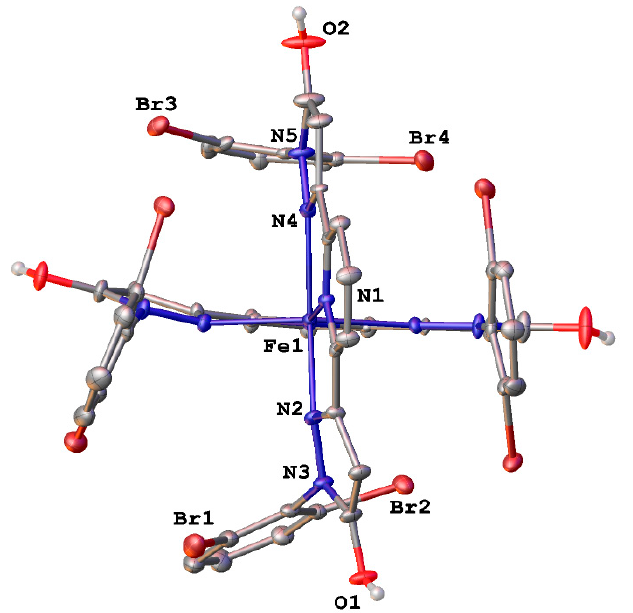
Figure 5. General view of the cation in [Fe( L H )] 2 (ClO 4 ) 2 as obtained from X-ray diffraction at 120 K. Non-hydrogen atoms are shown as thermal ellipsoids (p = 30%), hydrogen atoms except those of OH groups are omitted for clarity, and only labels of the heteroatoms in an asymmetric part of the unit cell are given. For [Fe( L Br ) 2 ](ClO 4 ) 2 and [Fe( L Me ) 2 ](ClO 4 ) 2 , see Figure S7 of ESI. Table 3. Main geometric parameters and continuous symmetry measures 1 as obtained from X-ray diffraction at 120 K for